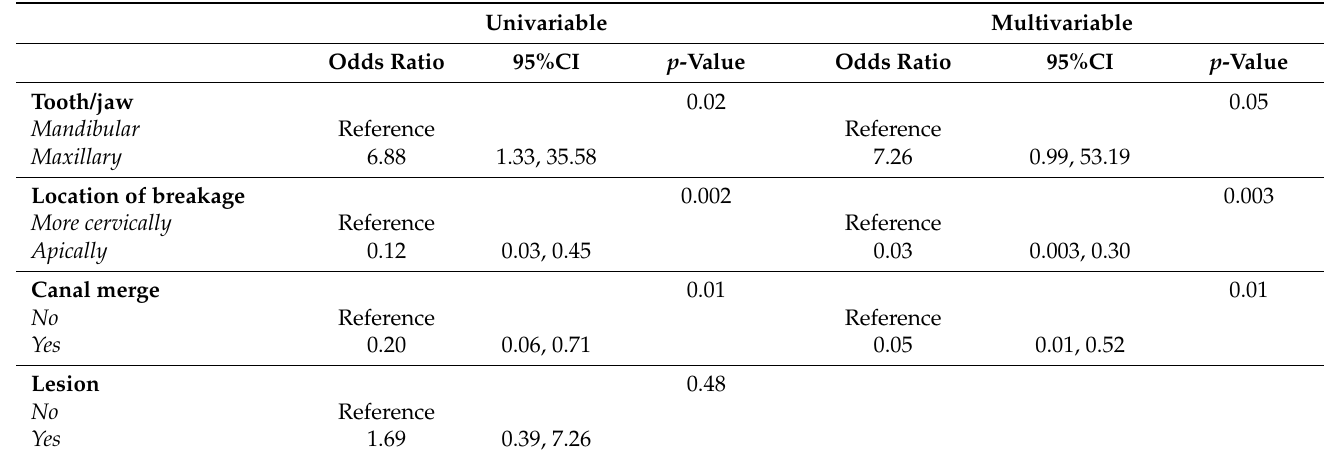
Table 4. Univariable and multivariable logistic regression for the effect of tooth and jaw, location of fracture within the root canal (converted to binary: more cervically to apically), canal merge and presence of lesion or otherwise, on treatment decision to remove or bypass versus retain the fractured instrument within the root canal, based on assessment through CBCT. Univariable Multivariable Odds Ratio 95%CI p -Value Odds Ratio 95%CI p -Value